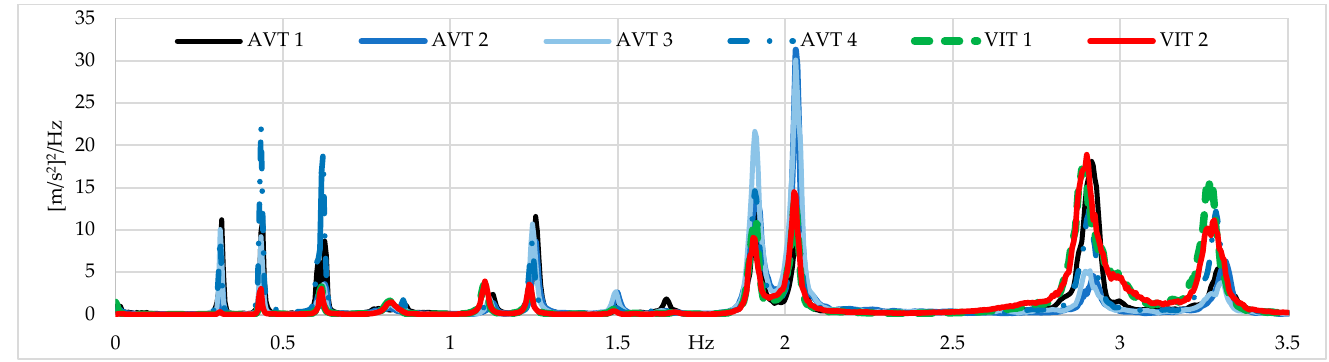
Figure 14. Three-axle 32-ton truck moving at a speed of 40 km/h on the Tablazo bridge.